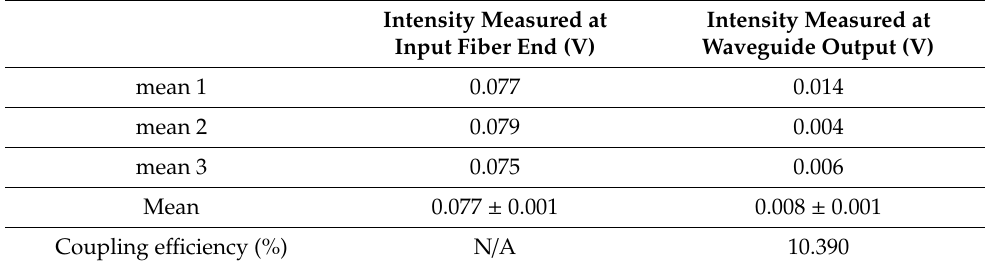
Figure 19. ( a ) Optical coupling from the taper fiber to the SU8 rib waveguide. ( b ) Light observed at the tip of the SU8 rib waveguide. Light appears nicely confined inside the core of the waveguide.